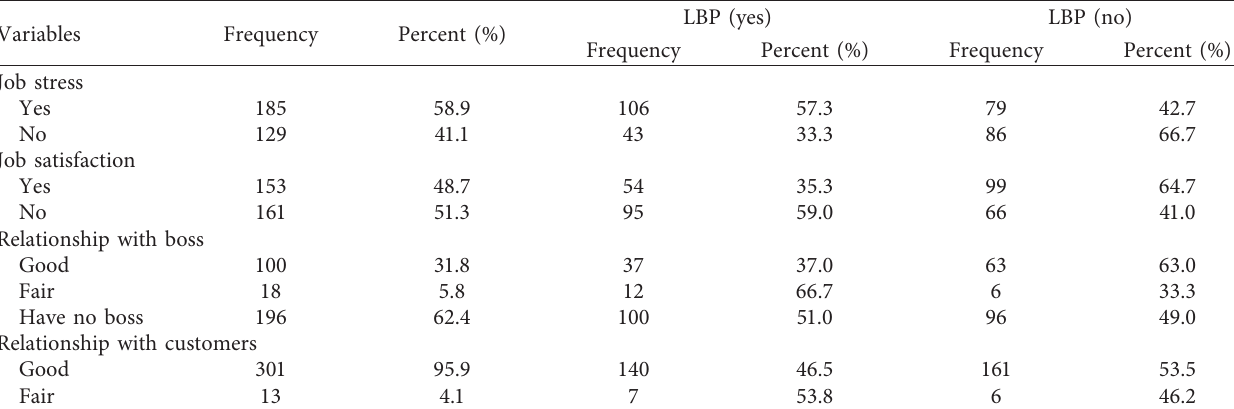
Table 3: Psychosocial characteristics and prevalence of LBP among the study participants, April 2018 ( n �